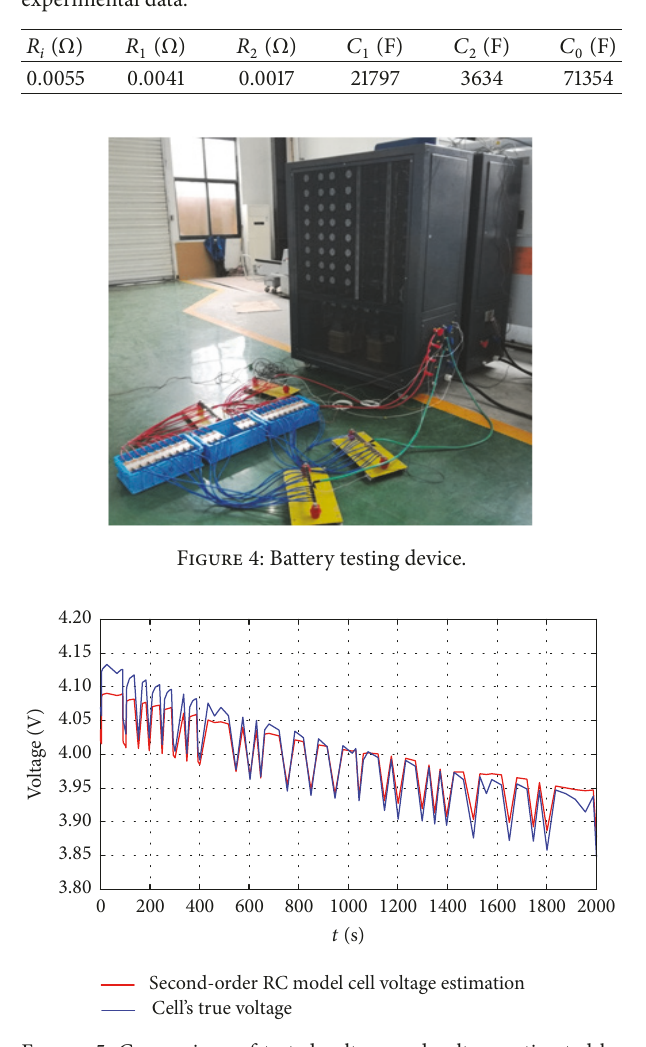
Figure 5: Comparison of tested voltage and voltage estimated by second-order RC model under driving condition.